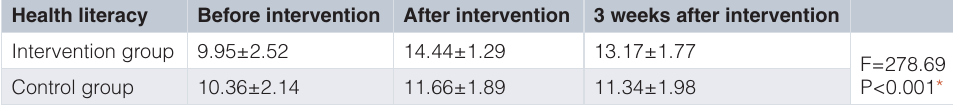
women with high-risk pregnancy presenting to selected health centers in Alborz province in